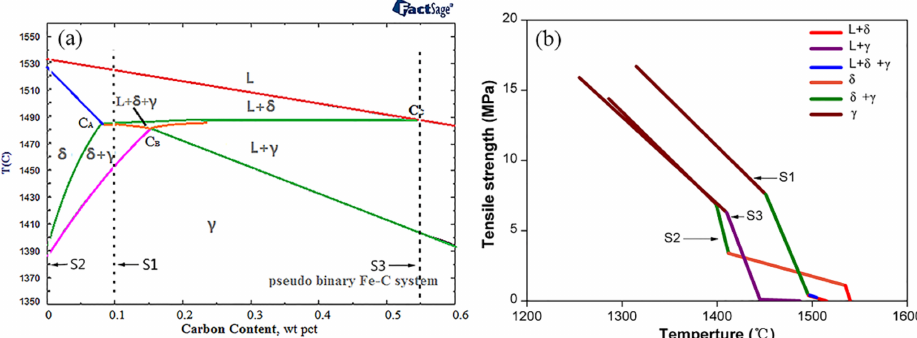
Figure 2. FactSage calculation of pseudo-binary Fe–C diagram ( a ) and the relationship between temperature and tensile strength during solidification ( b